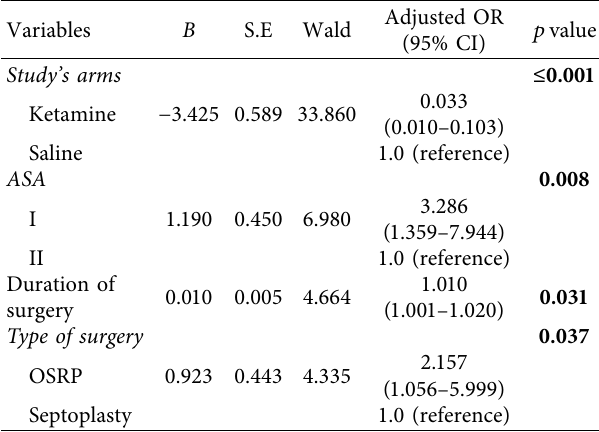
Table 4: Multivariate binary logistic regression analysis to predict